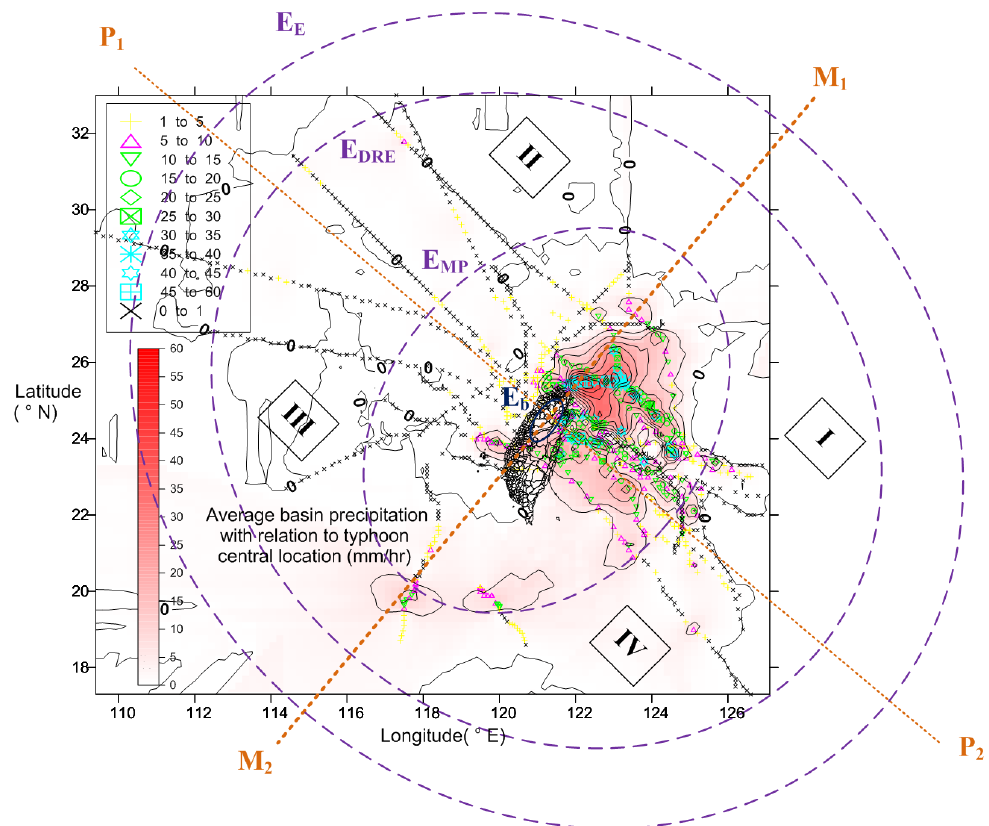
Figure 16. Construction results of heuristic forecast database for the Shihmen basin precipitation and duration characteristics curves with relation to the typhoon central